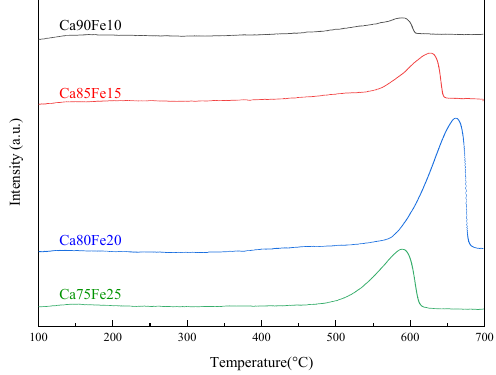
Figure 5. CO 2 –TPD curves of the catalysts.